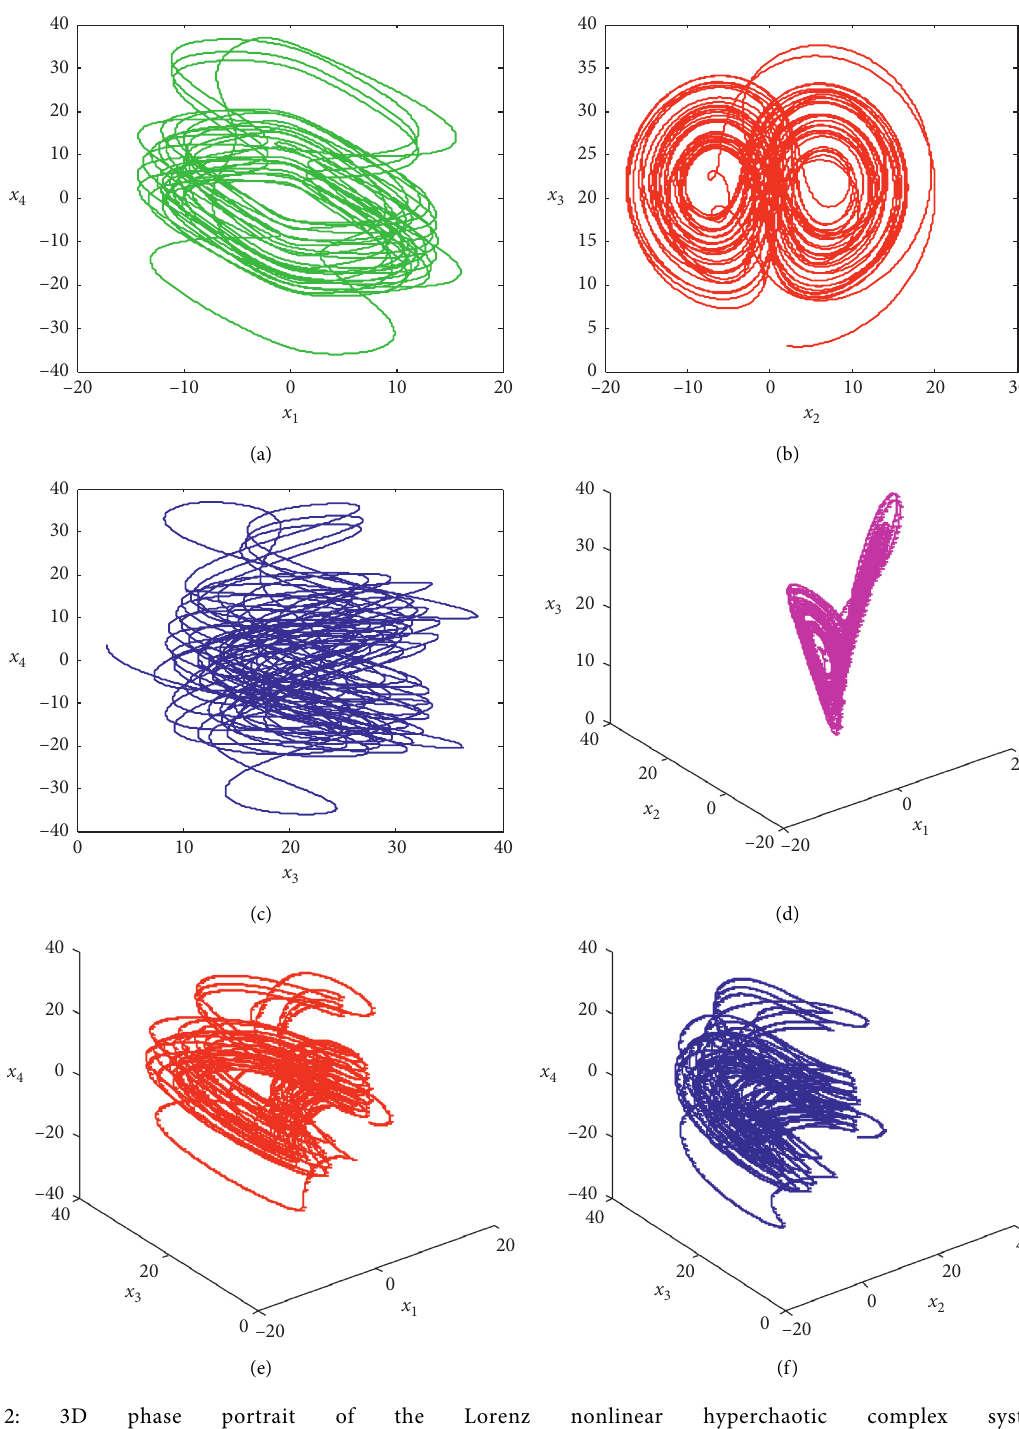
2: 3D phase portrait of the Lorenz nonlinear hyperchaotic complex system when a � 12 ,a � 23 , a � 1 ,a � 2 . 1 ,a � 6 , and a � 0 . 2at x ( 0 ) � [ 1 , 2 , 3 , 4 ] T 1 2 3 4 5 6